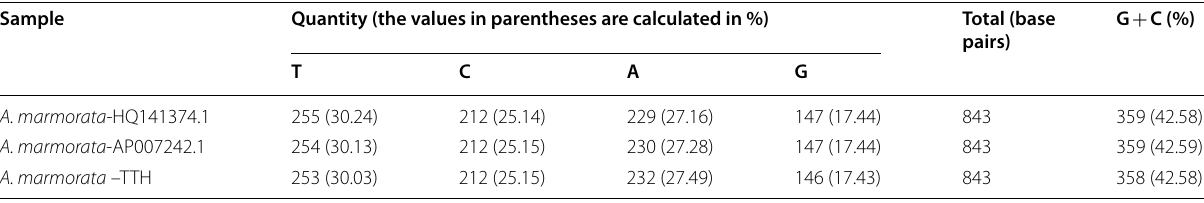
Table 2 Nucleotide composition of Anguilla marmorata’ s COI gene fragment in Thua Thien Hue, Viet Nam ( A. marmorata – TTH)